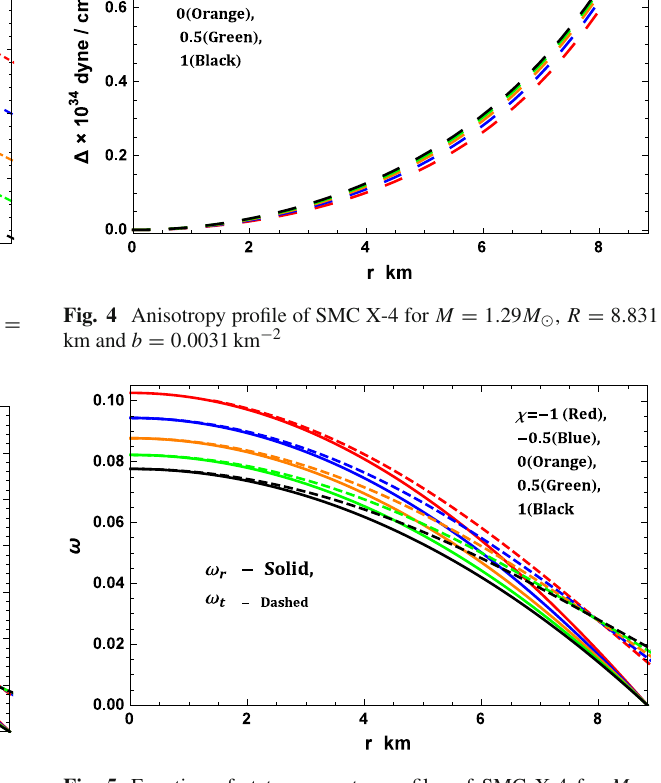
Fig. 3 Radial and transverse pressure profile of SMC X-4 w.r.t radial coordinate r for M = 1 . 29 M (cid:9) , R = 8 . 831 km and b = 0 . 0031km − 2